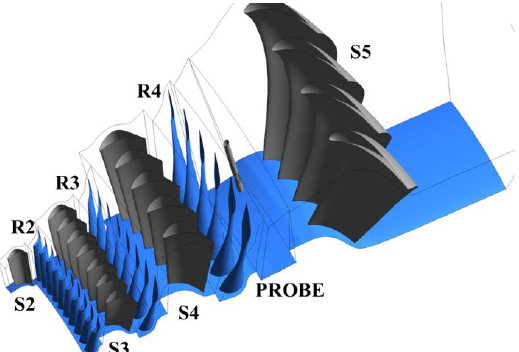
Fig. 2. Computation model of the variant with the extinction probe